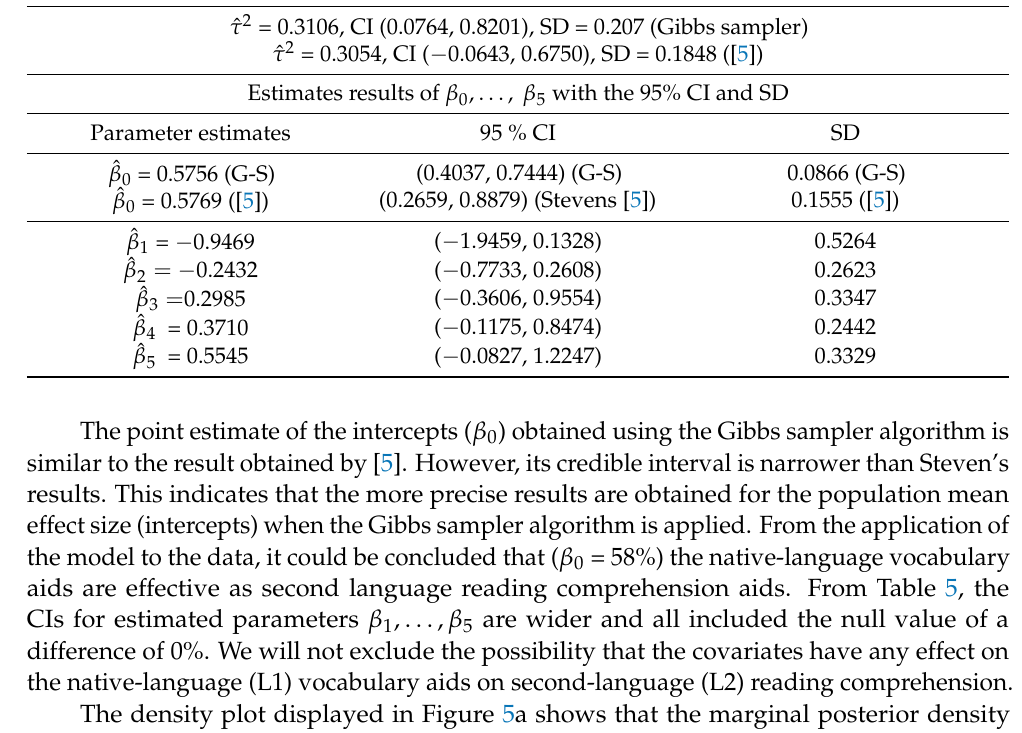
Table 5. Parameter estimates for the HBLD model using the Gibbs sampler for the case study. Estimate Result of τ 2 with the 95 % CI and SD ˆ τ 2 = 0.3106, CI (0.0764, 0.8201), SD = 0.207 (Gibbs sampler)